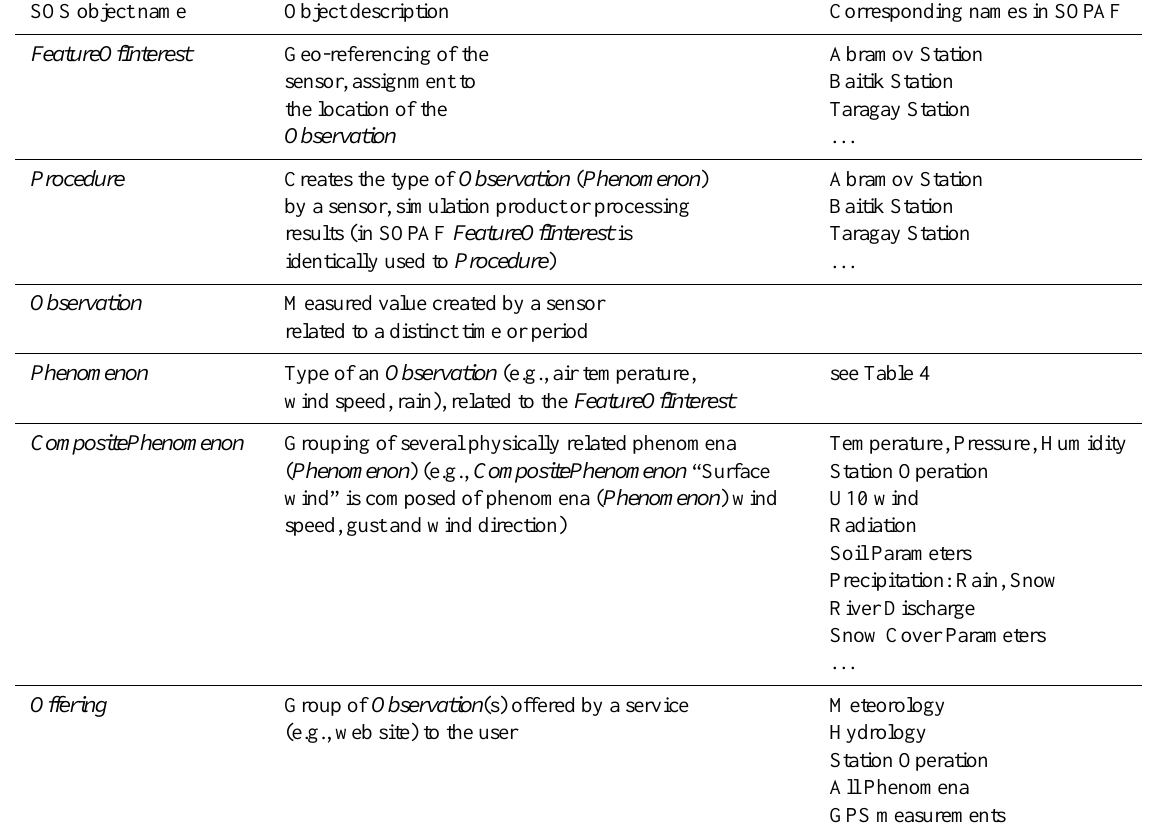
Table 3. Relationship between SWE definitions and their mapping to SOPAF